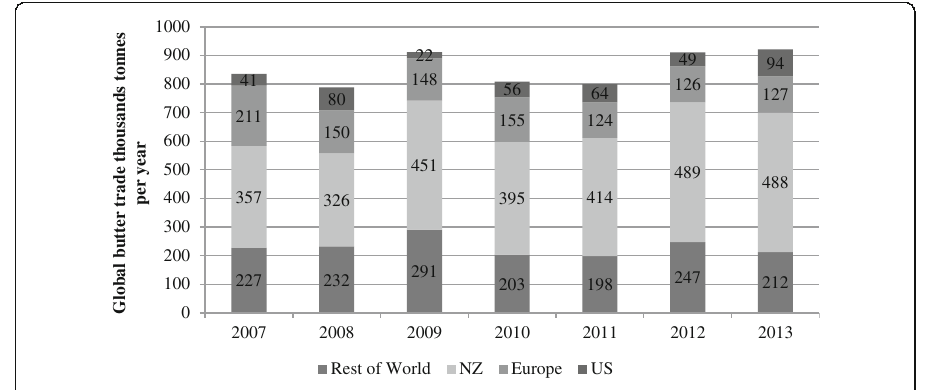
Fig. 4 Global butter trade from 2005 to 2013. Source: International Dairy Federation (2014)